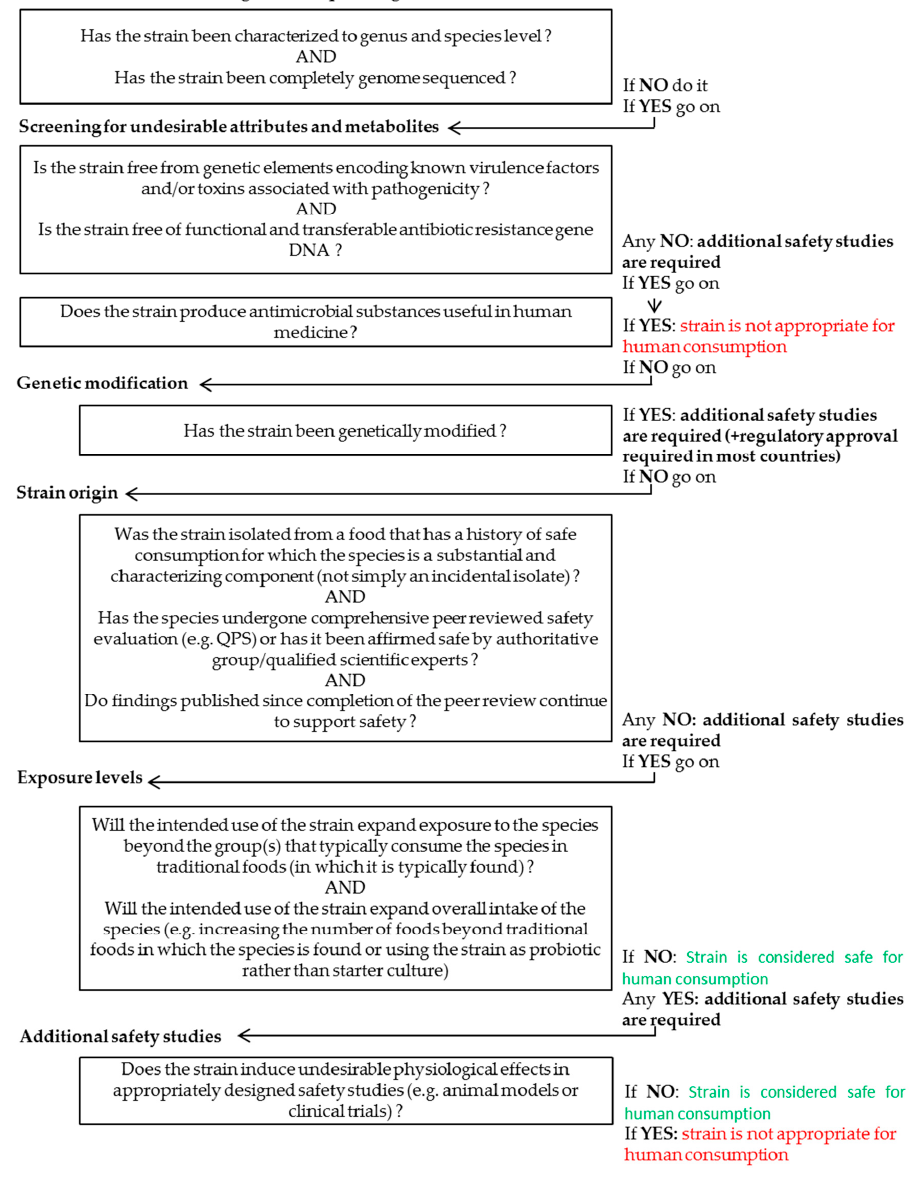
Figure 2. Decision tree for the safety assessment of microbial strains to be used in food applications [35].